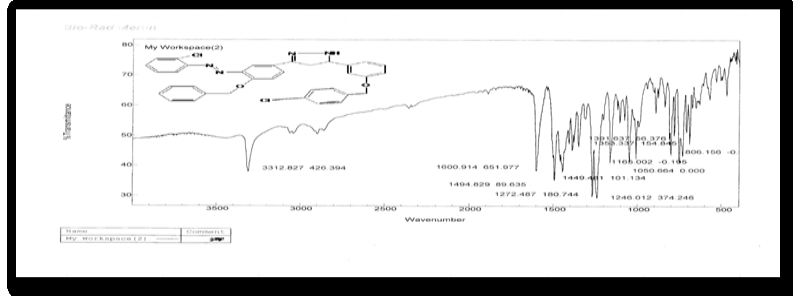
Figure 1: IR spectrum of compound (4j).